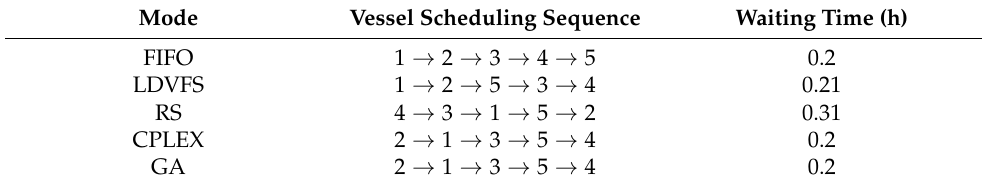
Table 6. Sample VSP instance and its optimal